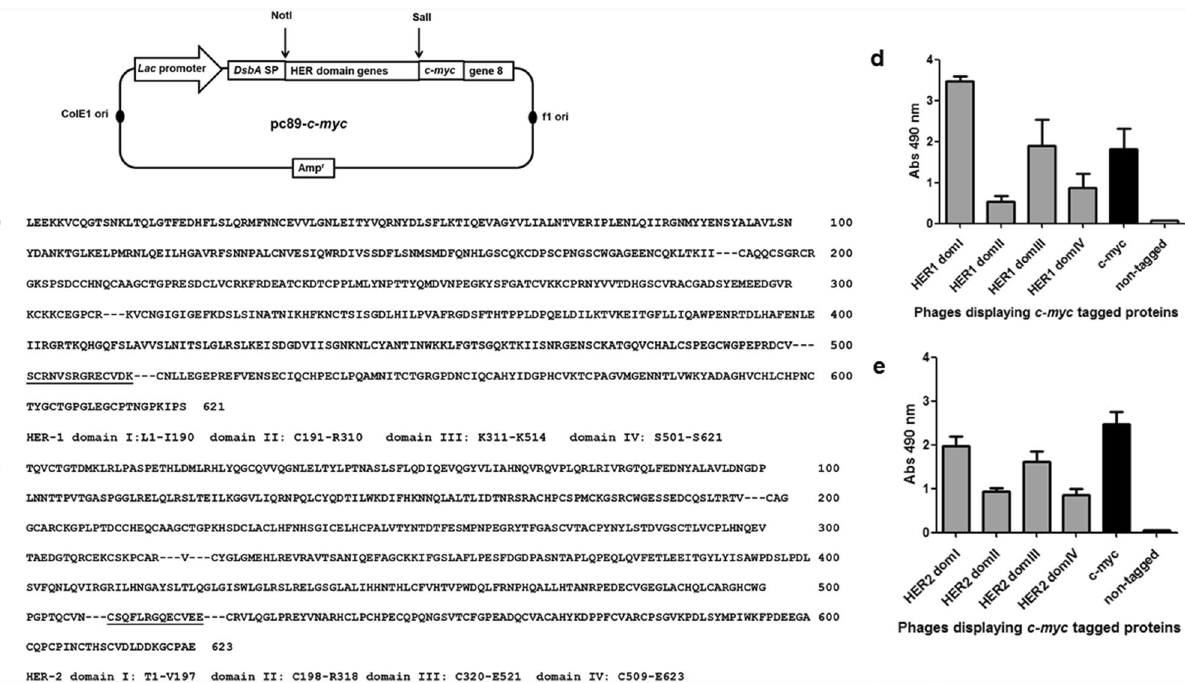
Figure 1. Display of HER-1/HER-2 domains on filamentous phages. Schematic representation of genetic constructs ( a ). Modified pC89- c-myc phagemid vector contains Lac promoter, phage and plasmid replication origins, an ampicillin resistance gene, and the genes coding for DsbA signal peptide, c-myc tag and filamentous phage PVIII. Genes coding for each HER domain were inserted between NotI and SalI restriction sites. HER-1 ( b ) and HER-2 ( c ) extracellular domain protein sequences and sequences of displayed domains are shown. Boundaries of the domains chosen for phage display are indicated with dotted lines. Two segments of 14 and 13 residues that are included by design in both the third and fourth domains of HER-1 and HER-2 respectively, appear underlined. ELISA recognition of HER-1 ( d ) and HER-2 ( e ) domains by the anti- c-myc tag antibody 9E10 is shown. Polyvinyl chloride microplates were coated with 9E10. Purified phages displaying domains of either HER-1 or HER-2 (5 × 10 10 cfu/mL) were incubated on coated plates. Bound phages were detected with an anti-M13 antibody conjugated to horseradish peroxidase. Phages rescued from cells transformed with the empty pC89- c-myc and pC89 (untagged) vectors were used as positive and negative controls